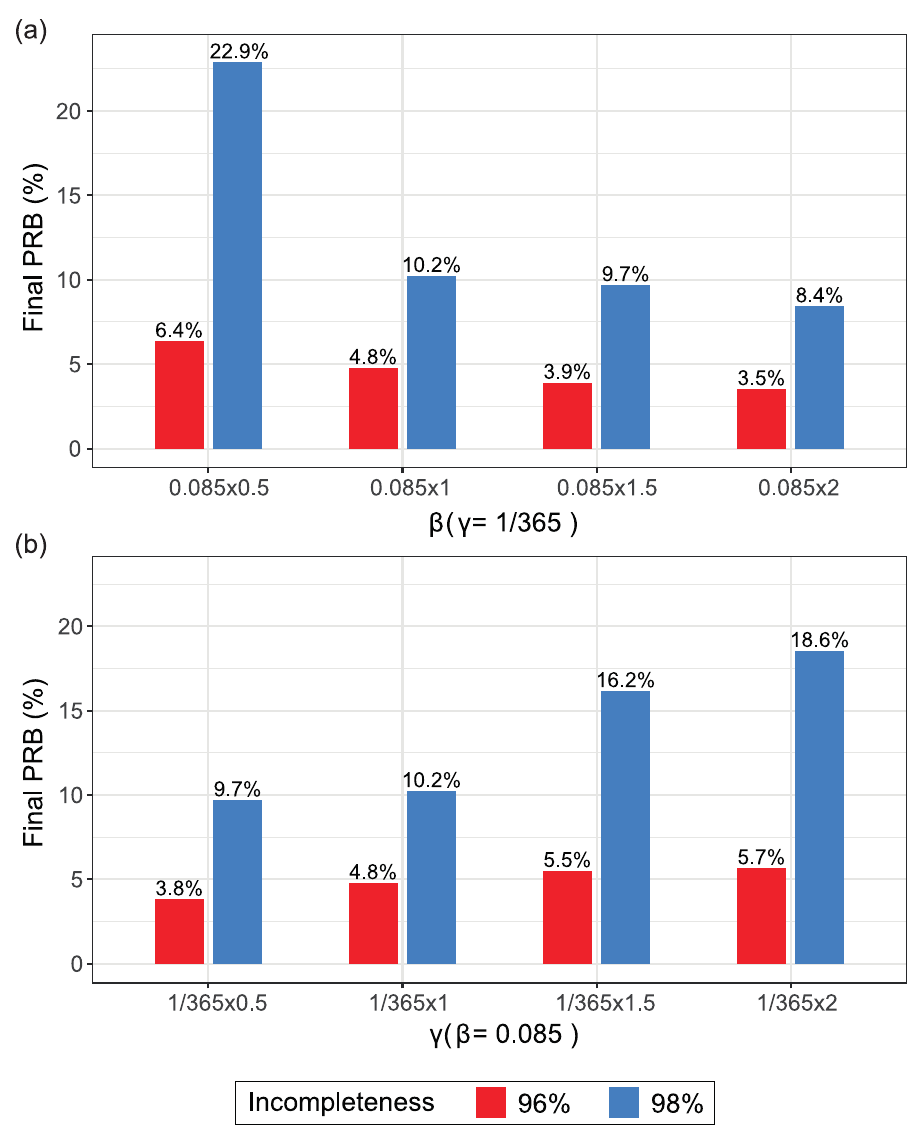
Fig 6. Final prevalence relative biases (PRBs) in hospital nodes for varying transmission parameters. The final PRBs in hospital nodes were calculated based on the simulations on AOK PLUS patient-movement networks, built by scale-up at incompleteness levels of 96% and 98%. In (a) we presented the final PRBs in hospital nodes for different values of β . In (b) we presented the final PRBs in hospital nodes for different values of γ .